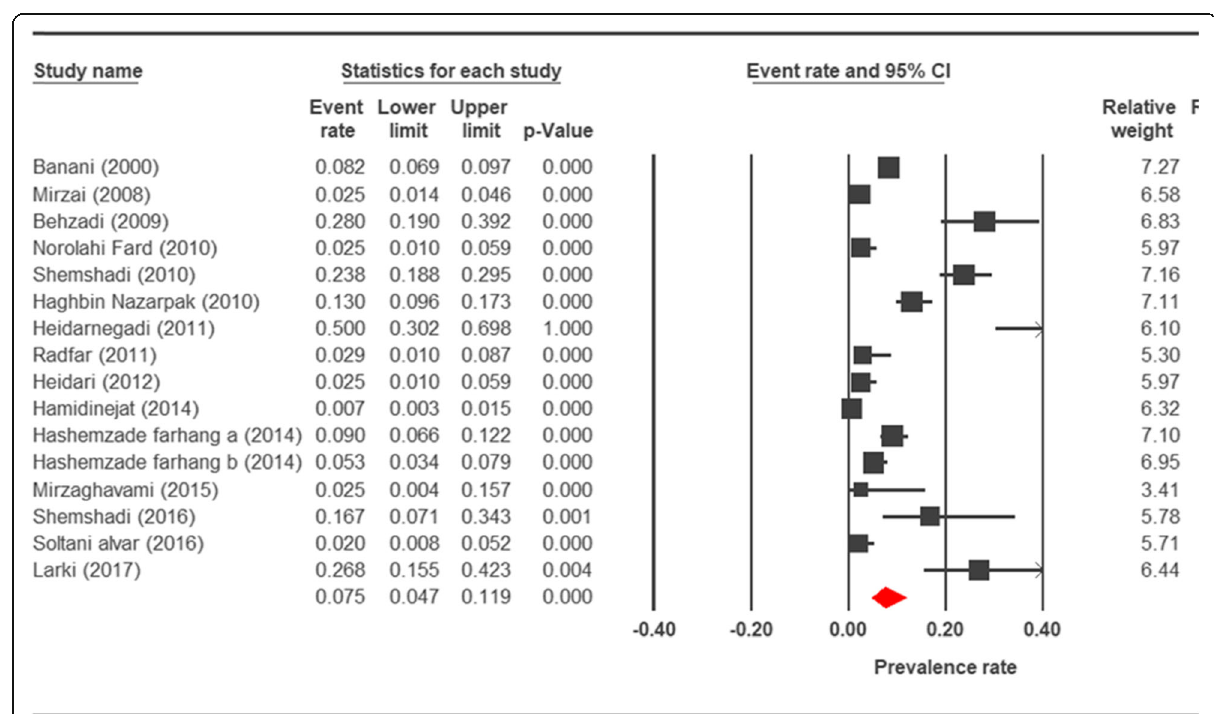
Fig. 2 Forest plot diagram showing the prevalence rate of Cryptosporidium infection in birds of